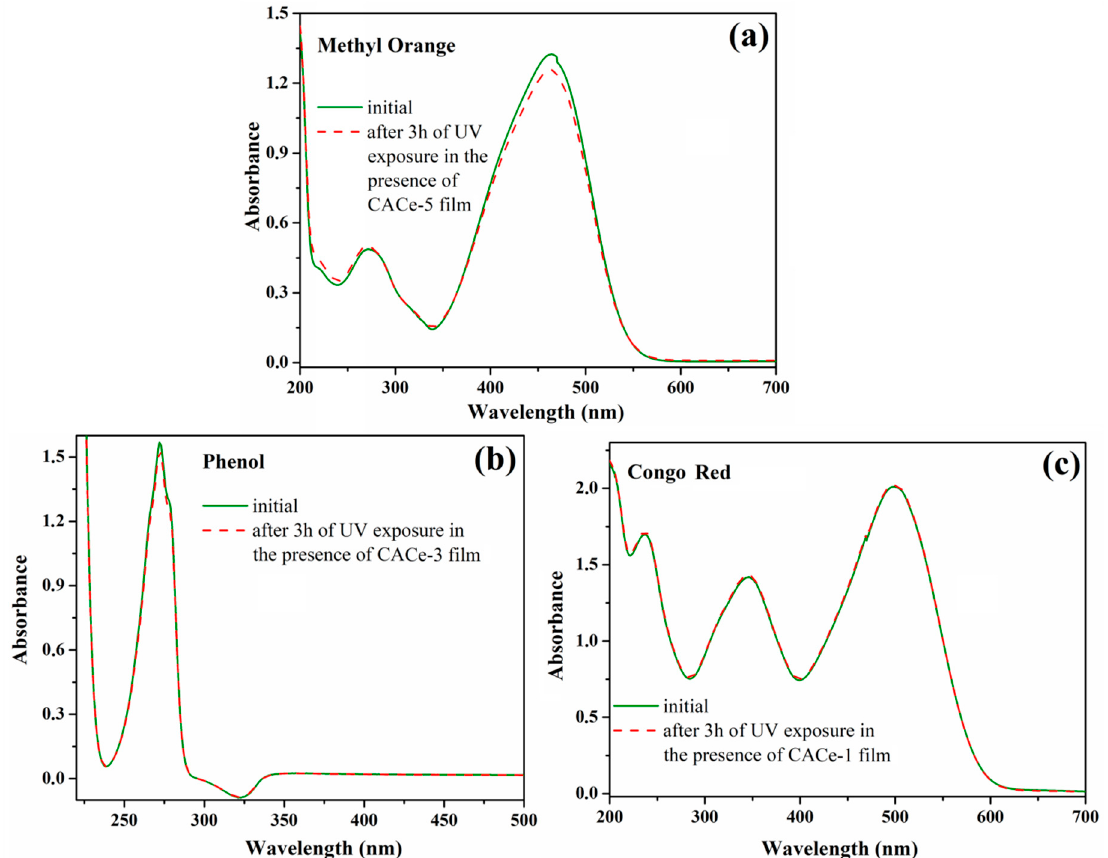
Figure 10. Changes of UV-Vis absorption spectra of aqueous Methyl Orange ( a ), phenol ( b ) and Congo Red ( c ) solutions in the presence of CA-CeO 2 films used as catalysts monitored after 3 h of UV irradiation exposure.